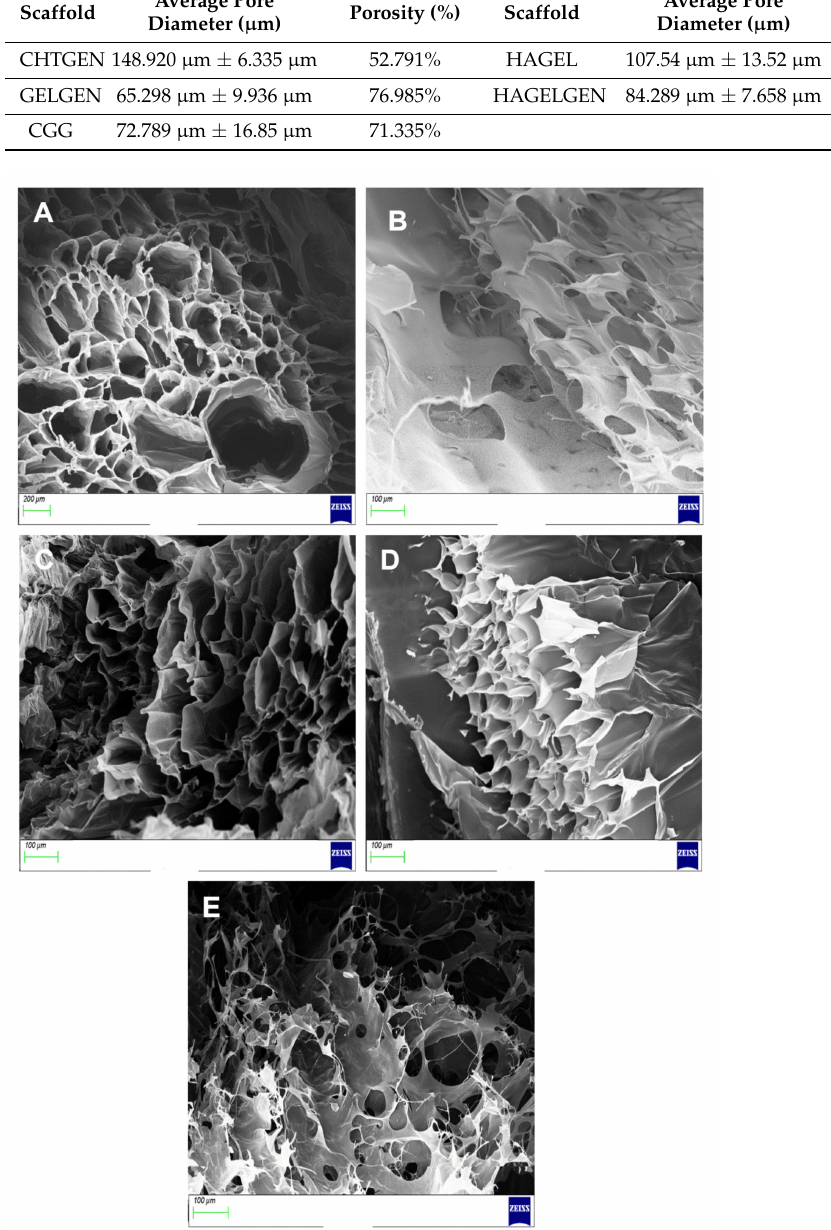
Figure 10. SEM images of ( A ) CHTGEN, ( B ) GELGEN, ( C ) CGG, ( D ) HAGEL and ( E )